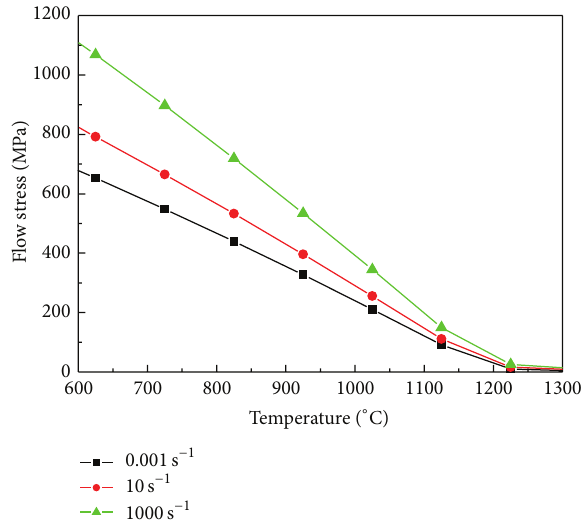
Figure 2: Temperature and strain rate dependent flow stress adopted in simulations. Table 2: The IFW processing parameters studied. Parameter Value Moment of inertia (kg ⋅ m 2 ) 1.178